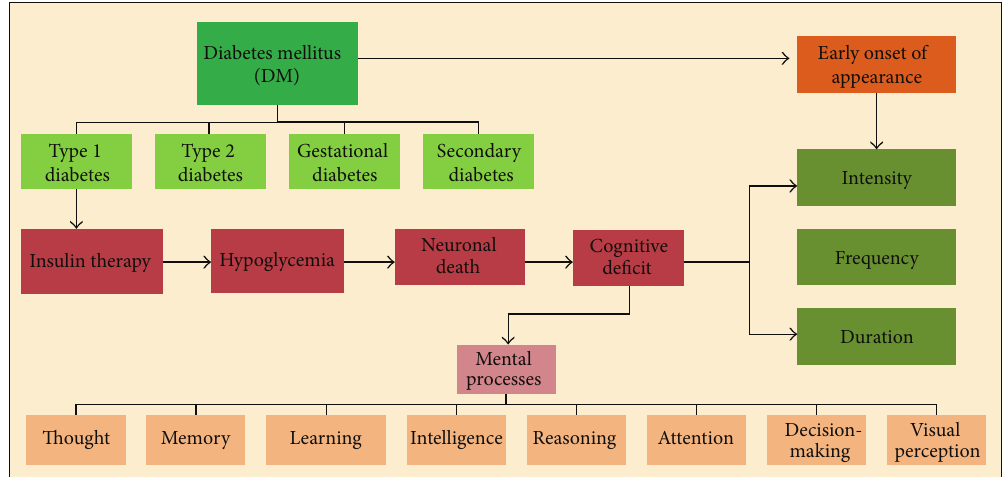
Figure 1: Insulin-induced hypoglycemia and its correlations with neuronal death and cognitive